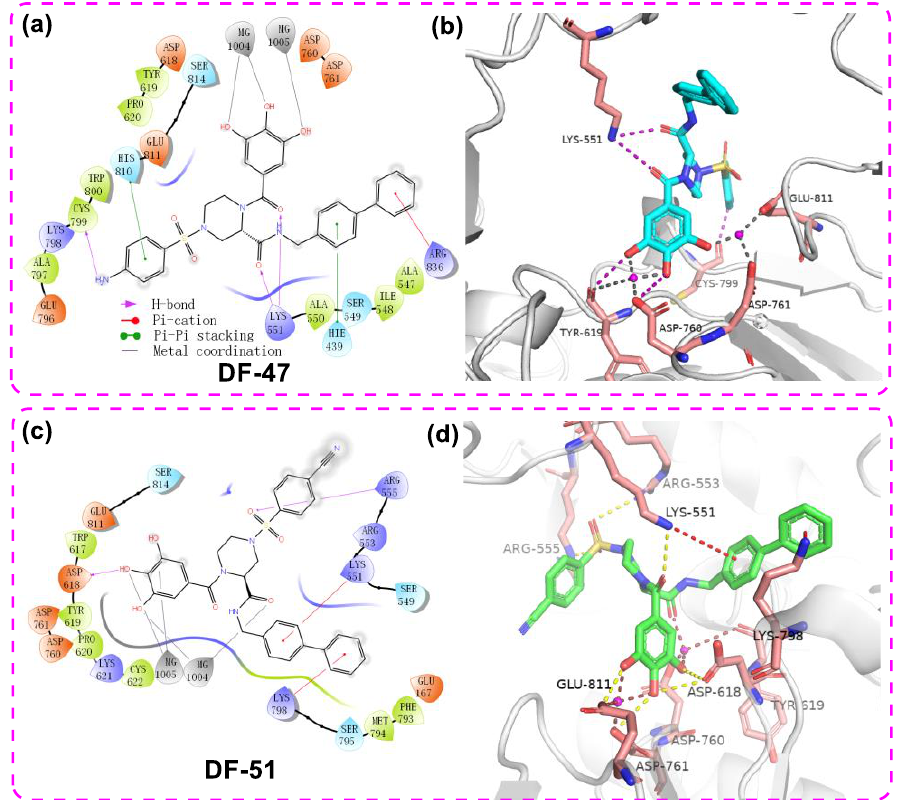
Figure 4. The 2D ligand–protein interaction diagram ( a )/3D docking pose ( b ) of DF-47 with DENV3 NS5 and the 2D ligand–protein interaction diagram ( c )/3D docking pose ( d ) of DF-51 with SARS-CoV-2 RdRp (PDB ID: 7BV2). The pink spheres represent Mg 2+ . The purple arrows indicate the hydrogen bonds; the red line represents Pi–cation interaction; the gray line represents metal coordination; the green lines represent pi-pi